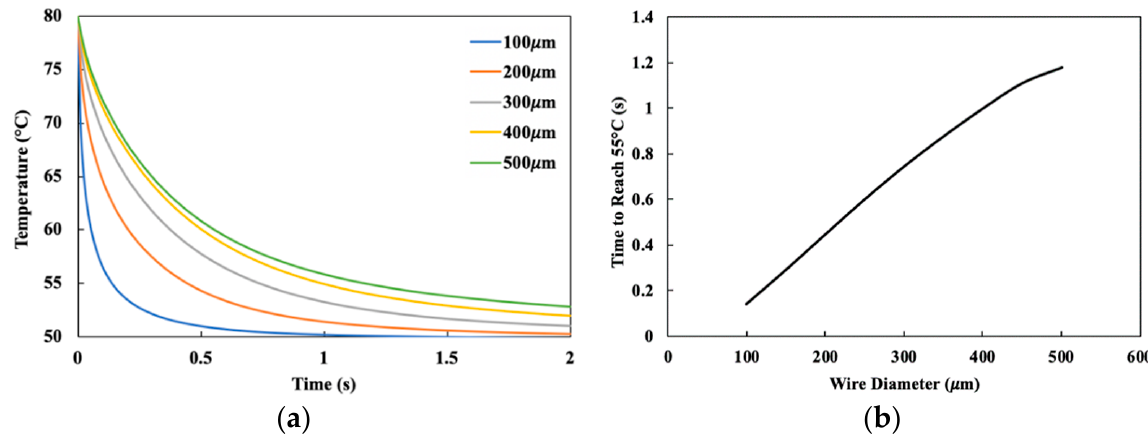
Figure 4. Transient thermal analysis results for varying wire diameters. ( a ) Selected transient maximum temperature distributions for varying wire diameters; ( b ) Time for each wire diameter size to reach 55 ° C.